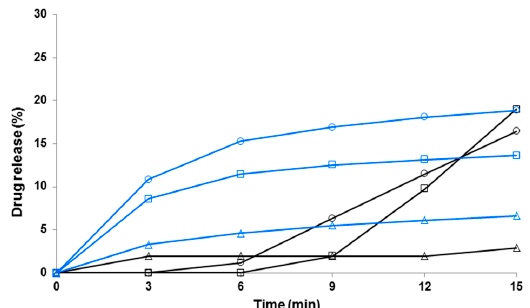
Figure 7. Early-phase dissolution of piroxicam (PRX)-loaded hydroxypropyl methylcellulose (HPMC) nanofibers freely set into the dissolution baskets ( n = 6). The ratio of a carrier polymer (HPMC) and